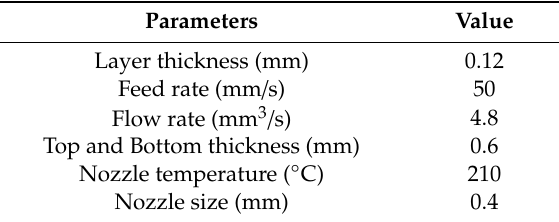
Table 2. Process parameters and their levels used in this